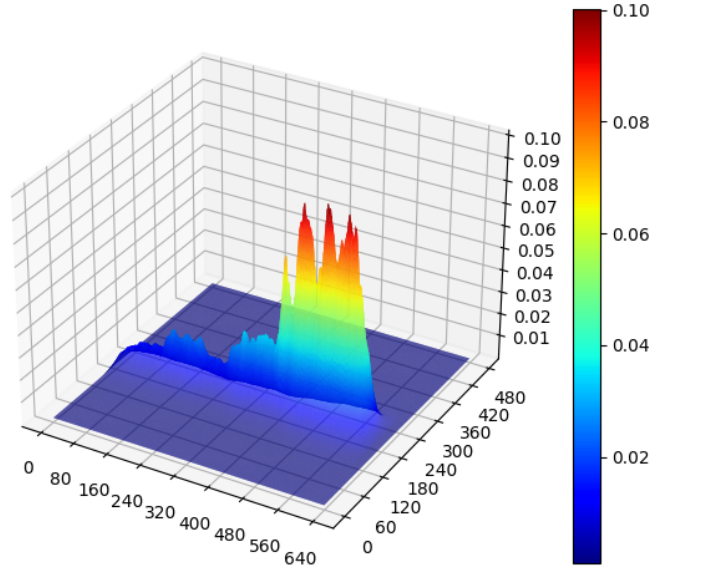
Figure 6. Spatial detector confidence distribution of FP and FN. Figure 5. Spatial detector confidence distribution of False Positive (FP) and False Negative (FN).